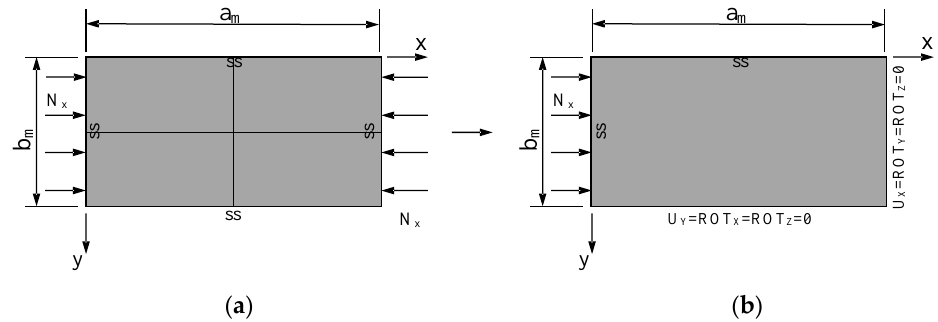
Figure 10. Two- dimensional sketch of the geometry’s ( a ) full and ( b ) quarter model and its boundary conditions for the case of compressive buckling.